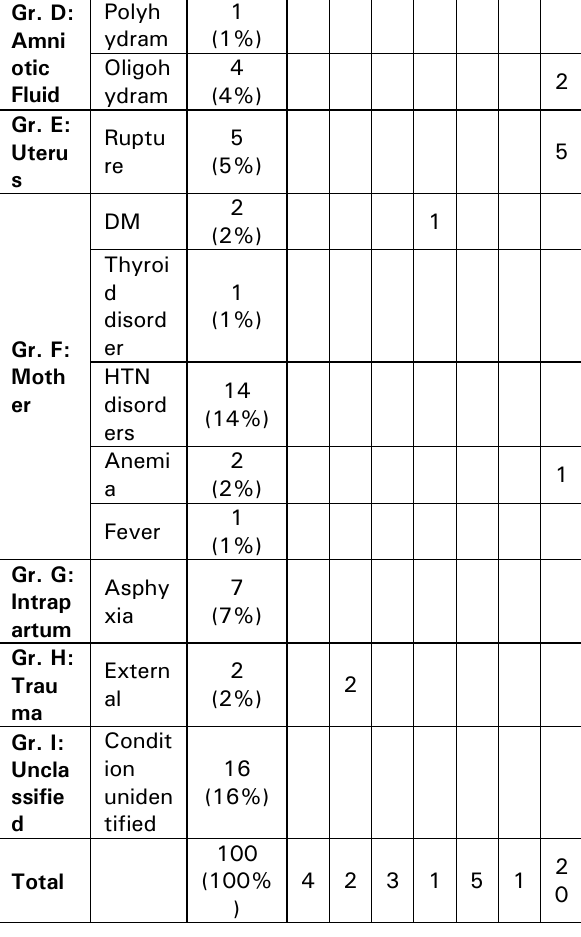
Table 4: Classification of Stillbirths by Relevant Condition at Death (ReCoDe)